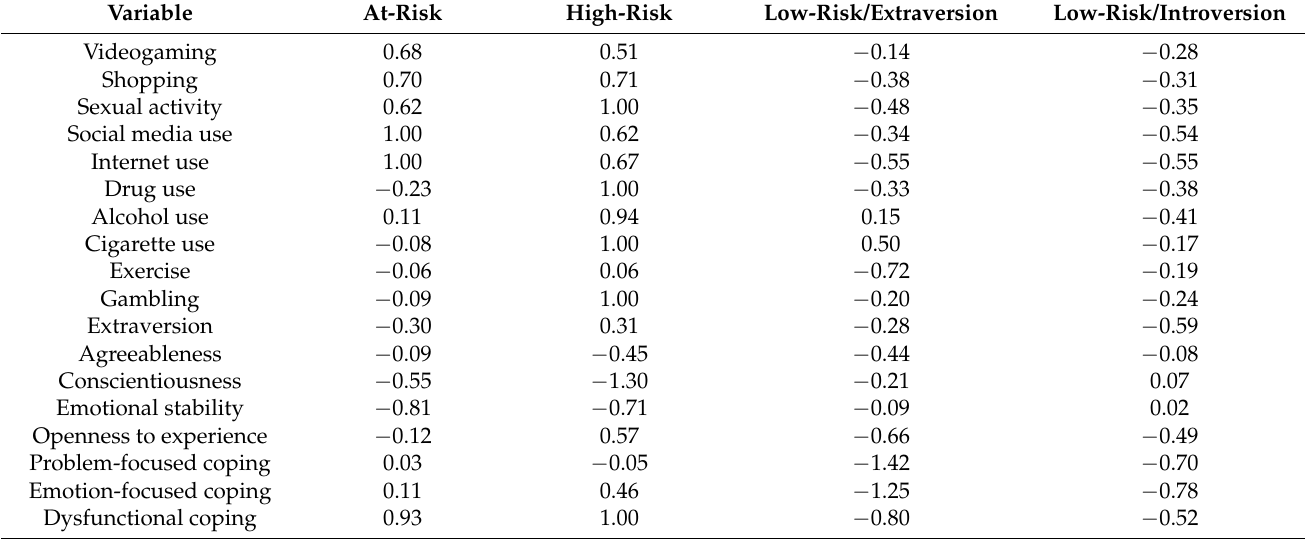
Table 4. Standardised score from the sample mean in the New Zealand cohort.